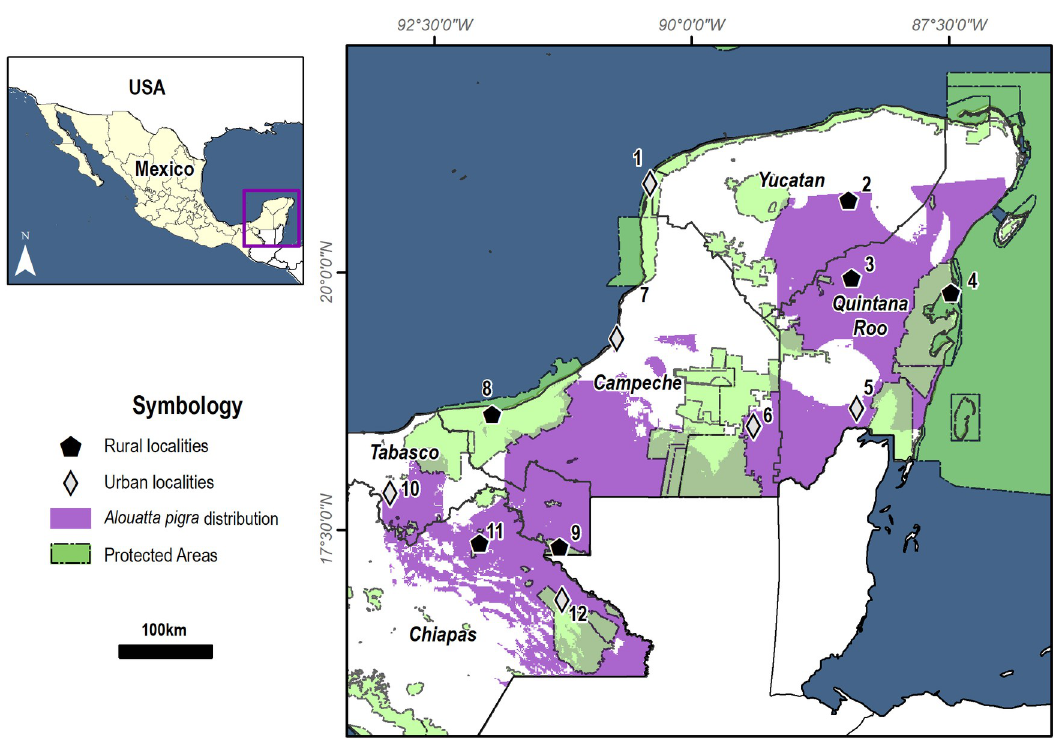
Fig 1. The area where black howler monkeys are distributed and the communities that were randomly selected. The 12 communities (6 rural and 6 urban) were within Natural Protected Areas. 1: Celestu´n, 2: San Francisco Tinum (Yucata´n); 3: Dzoyola´, 4: Punta Allen, 5: Bacalar (Quintana Roo); 6: Xpujil, 7: Champoto´n, 8: Puerto Rico (Campeche); 9 Redencio´n del Campesino, 10: Playas del Rosario (Tabasco); 11: Jerusalen, 12: Nueva Palestina (Chiapas). � Digital cartography used in this Figure is